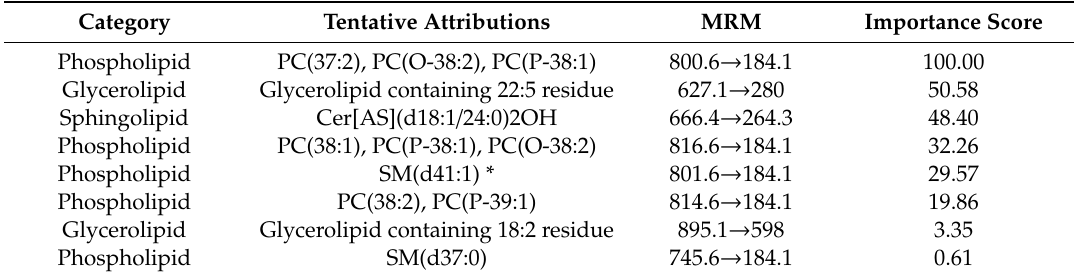
Table 2. List of top lipid ions ranked by importance score for prediction of genotype using the elastic net